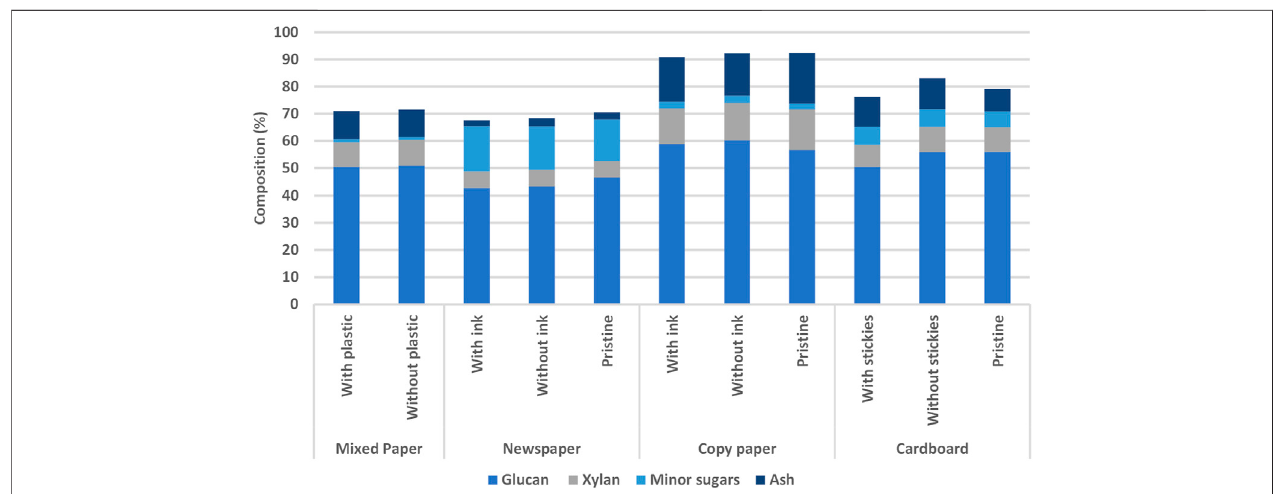
FIGURE 5 | Compositional analysis of MSW paper types. The balance of composition (not shown) consists of glucan, xylan, lignin, extractives, and minor sugars (arabinan, mannan, and galactan).